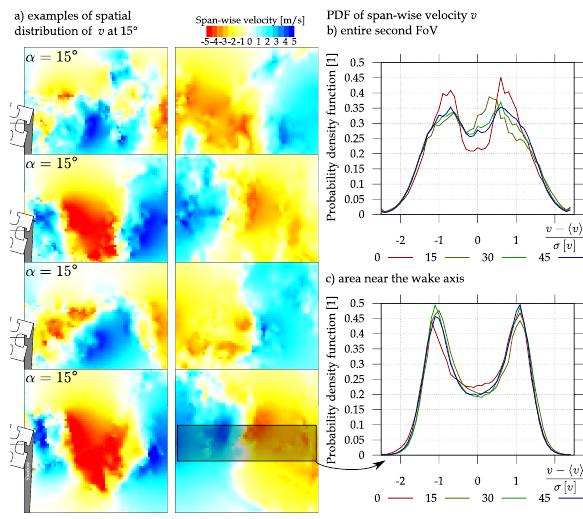
Fig. 6. Left : example of few instantaneous fields of span-wise velocity v at angle α = 15 ◦ and stream-wise velocity u = 5m / s. Right : probability density functions of span-wise velocity in the entire second field of view ( b ) and in the limited area ( c ) near the wake axis. This area is depicted in the bottom image of the instantaneous velocity as a gray